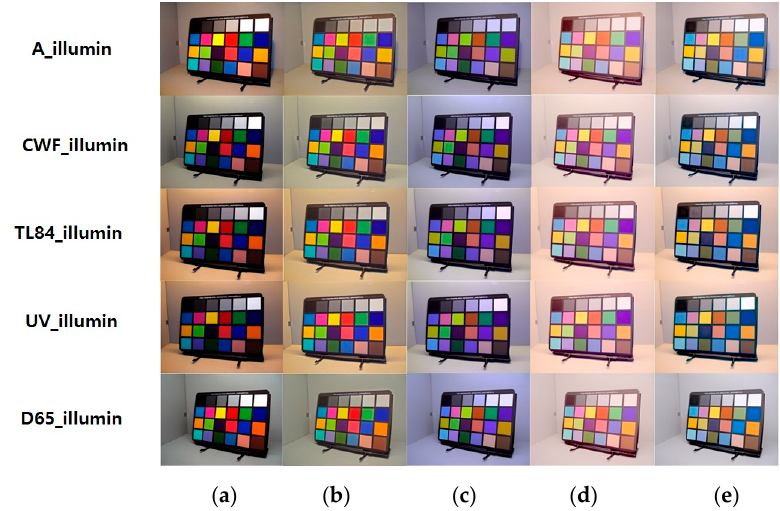
Figure 10. ( a ) Original images captured under five standard illuminations and resulting images of ( b ) iCAM06, ( c ) Reinhard’s method, ( d ) Choi’s method, and ( e ) the proposed